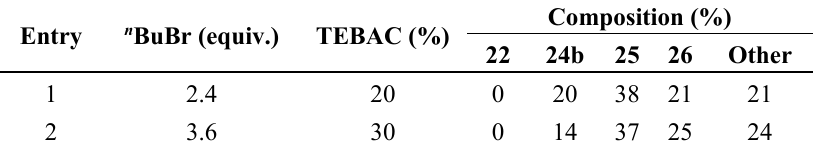
Table 7. The alkylation of diethyl cyanomethylphosphonate ( 22 ) with butyl bromide under solventless MW conditions in the presence of triethylbenzylammonium chloride (TEBAC). Entry n BuBr